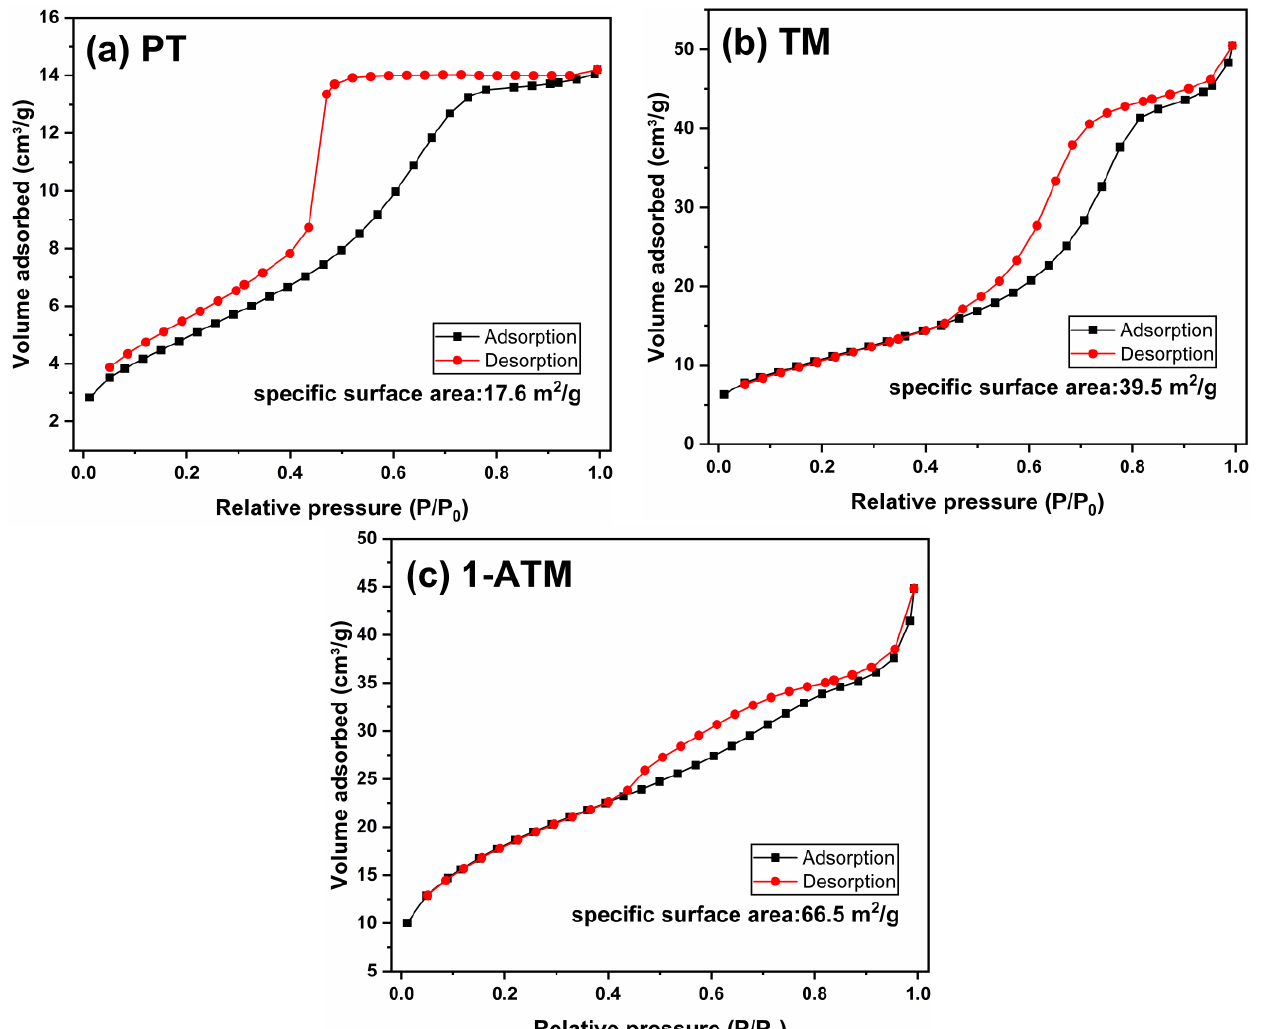
Figure 4. Nitrogen adsorption–desorption isotherms of PT ( a ), TM ( b ) and 1-ATM ( c ).